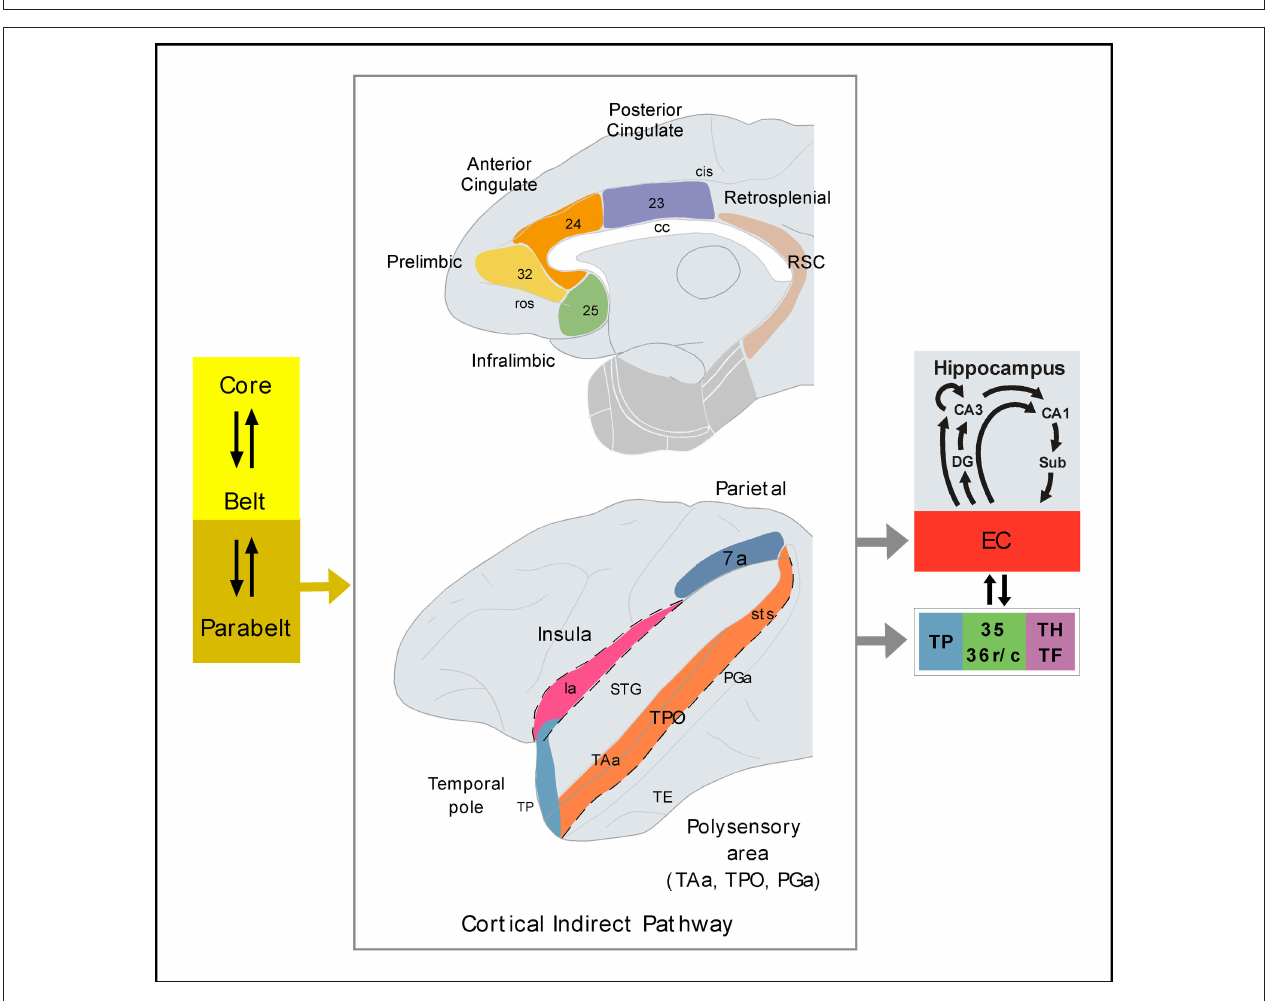
Figure 2 | Direct auditory pathway to the medial temporal cortex. (A) Core and belt areas of the auditory cortex, shown in the lateral view of the primate brain, have dense and reciprocal connections. Belt areas have dense connections with parabelt areas, where the projection to the parahippocampal region originates, i.e. the direct pathway (B) The architectonic areas that comprise the parahippocampal region are